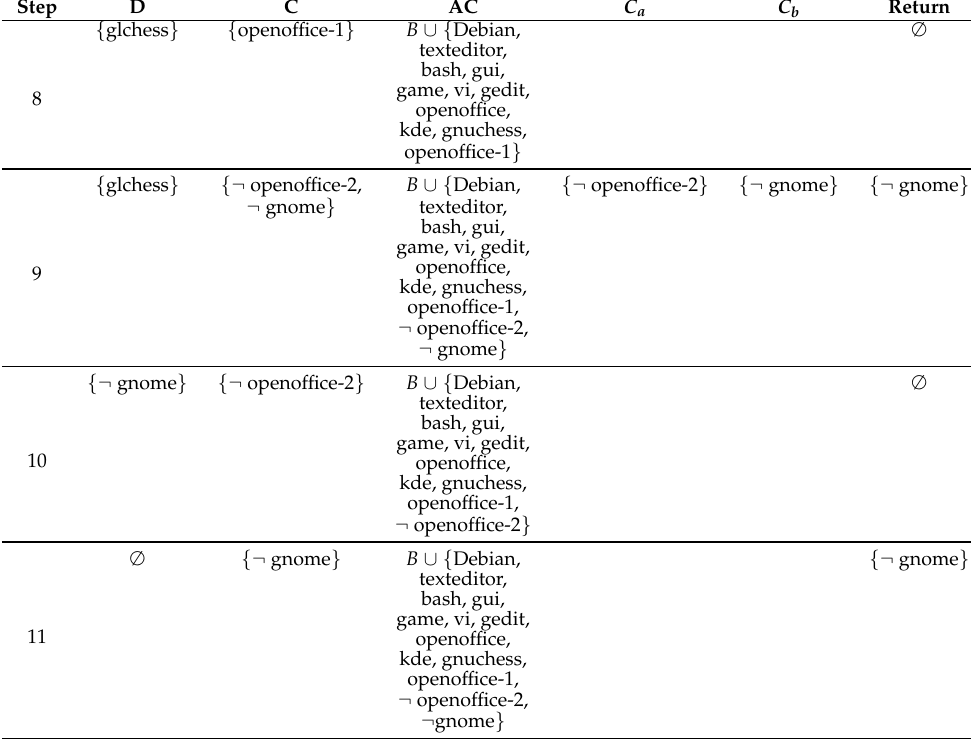
Table 8. Tracking of the F AST D IAG execution of configuration example of Figure 7 (part